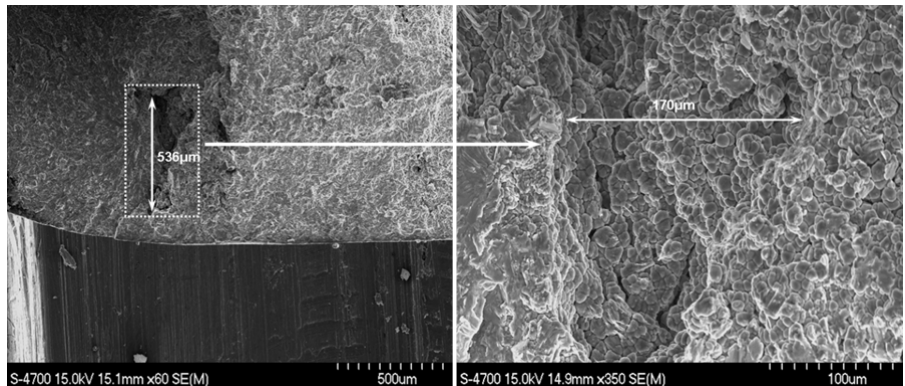
Figure 10. SEM image of a crack initiation site in specimen 34-26 (Fatigue life = 542,156 cycles) [5].